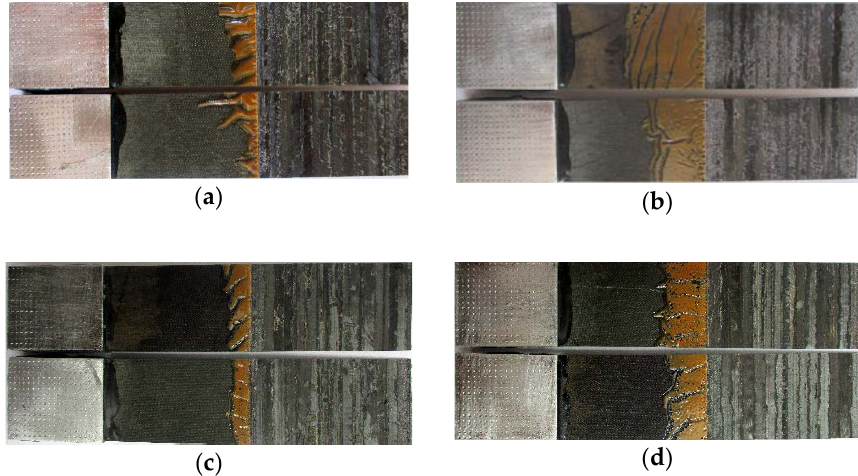
Figure 7. Representative fracture surfaces of the scarf joints after loading in tension ( a ) REF; ( b ) REF+TD1; ( c ) TD1+DI; ( d ) TD1+DI2.